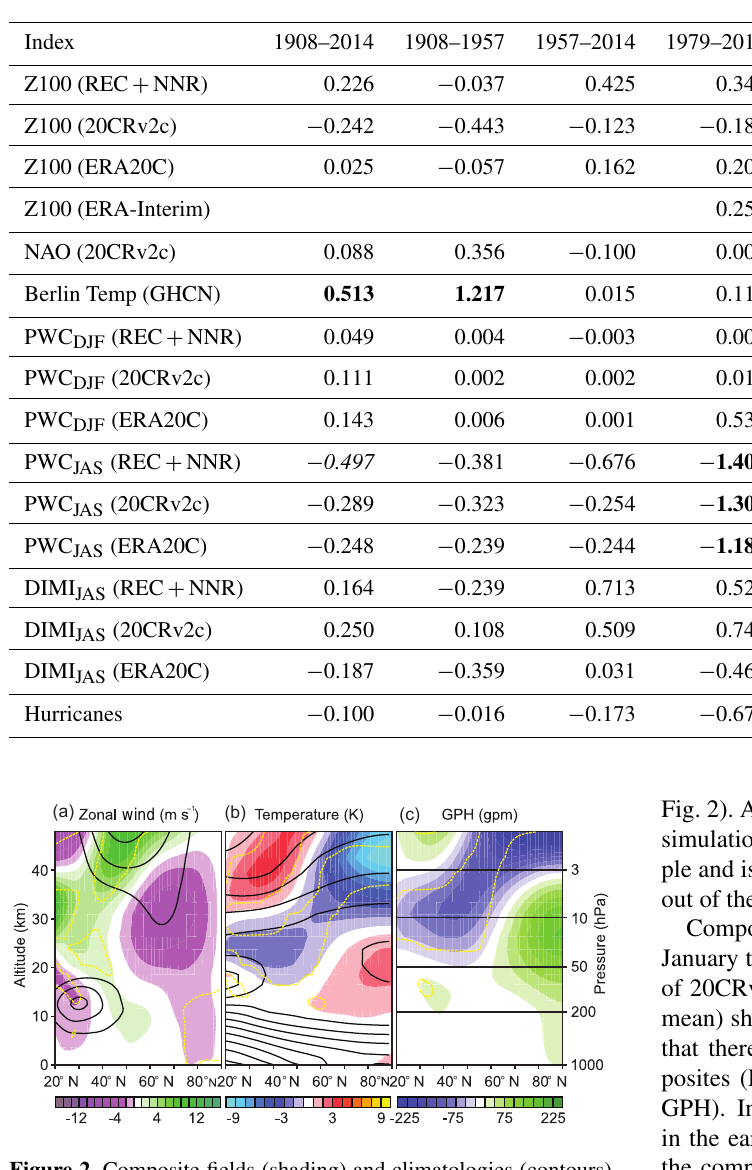
Figure 2. Composite fields (shading) and climatologies (contours) since 1979 in ERA-Interim, January–March for easterly minus westerly QBO phases (50hPa, November–December) for zonal av- erages of (a) zonal wind (contours: 20 to 60ms − 1 in steps of 10ms − 1 ), (b) temperature (contours: 200 to 300K in steps of 10K) and (c) GPH. Yellow dashed lines indicate significant difference ( p = 0 . 05). The corresponding figure for 20CRv2c and ERA-20C is given in Fig.